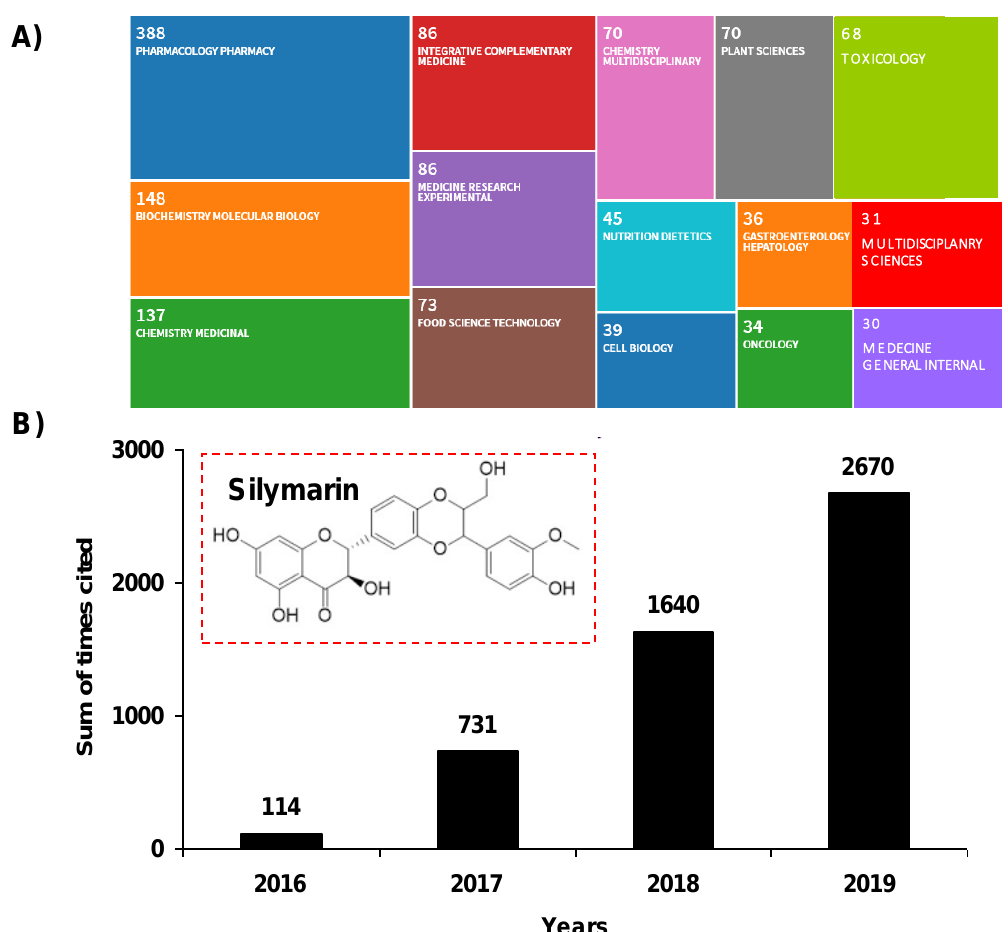
Figure 1. ( A ) Tree map of fields for silymarin terms. The record count in each rectangle is the total number of articles published in the last four years (2016 to 2020). The count includes Early Access articles that are fully peer-reviewed, citable, and published. ( B ) Sum of times cited. This is the total number of citations to silymarin in the results set. Inset: chemical structure of silymarin.